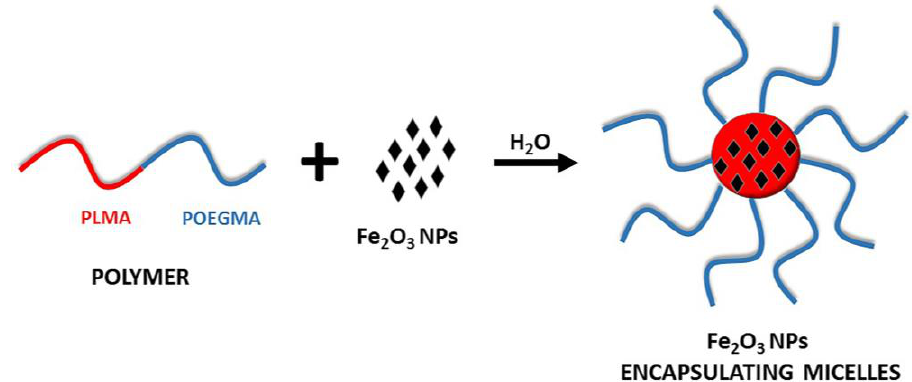
Figure 1. Colloidally stable ( a ) and unstable ( b ) mixed solutions of PLMA 22 - b -POEGMA 32 micelles a Determined by size exclusion chromatography (SEC), b Determined by nuclear magnetic resonance ( 1 H NMR), c Determined by dynamic light scattering (DLS) at 90 ◦ . containing 10 and 20 wt % of magnetic nanoparticles (NPs) relative to PLMA, respectively.